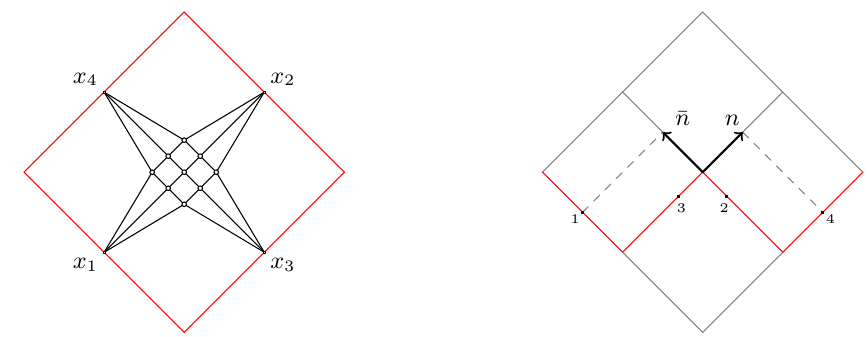
Figure 4 . The flux-tube factorization relies on lightcone coordinates to parametrize the positions of the four points x 1 , 2 , 3 , 4 along a null conformal frame (square). In the case of interest, i.e. for spacelike separations, x 2 < 0 , the null square is the Poincaré patch of (conformally compactified) ij R 1 , 1 ⊂ R 1 , 3 , as shown in the right panel. Two points are placed at the boundary of the patch, with n · x 1 = ¯ n · x 4 = 1 and n, ¯ n two orthogonal lightlike vectors, n 2 = ¯ n 2 = 0 , n · ¯ n = 1 . The remaining points are sitting at n · x 2 = z and ¯ n · x 3 = ¯ z , with z, ¯ z both real and